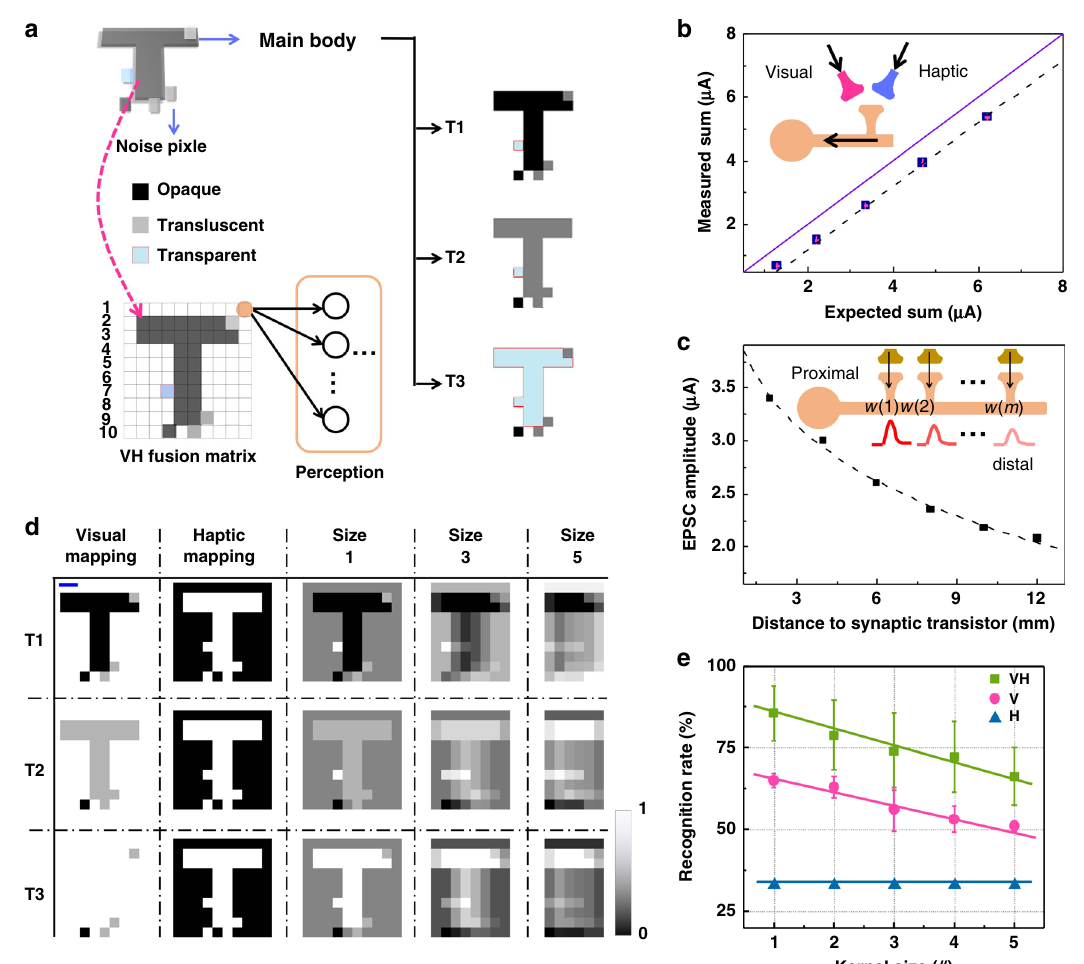
Fig. 4 The BASE matrix based visual-haptic fusion for multi-transparency pattern recognition. a The multi-transparency alphabetic patterns (top left) and the visual-haptic fusion matrix (bottom left). The sensing data of each pattern obtained from the VH fusion matrix are fed into a perceptron for recognition. Each pixel could be opaque (top right, shown in black), translucent (middle right, shown in gray), or transparent (bottom right, shown in light blue). The patterns are labeled based on the shape of the main body and their transparency. For example, the ‘ T1 ’ , ‘ T2 ’ , and ‘ T3 ’ denote the ‘ T ’ shape patterns which are opaque, translucent, and transparent, respectively. b The fusion results of two equidistance inputs. Two voltage inputs with different amplitudes are applied to a synaptic transistor through ionic cable with two isometric branches. The expected sum is the arithmetic summation of the EPSCs by individually triggering the two inputs, and the measured sum is the EPSCs by simultaneously triggering the two inputs. c The output measured from different inputs that are connected to the synaptic transistor through one common ionic cable. The weight for each input thereby annotated as w (1) to w ( m ). d The normalized mapping results based on unimodal information (visual or haptic) and VH fusion information. n-VH fusion data is merged from every 1, 3, and 5-VH units to 1 synaptic transistor in each line of the VH fusion matrix. The scale bar (in blue) is 5 mm. e The recognition rates for the mapping of unimodal and bimodal modes with kernel sizes of 1 – 5, respectively. The error bars are the standard